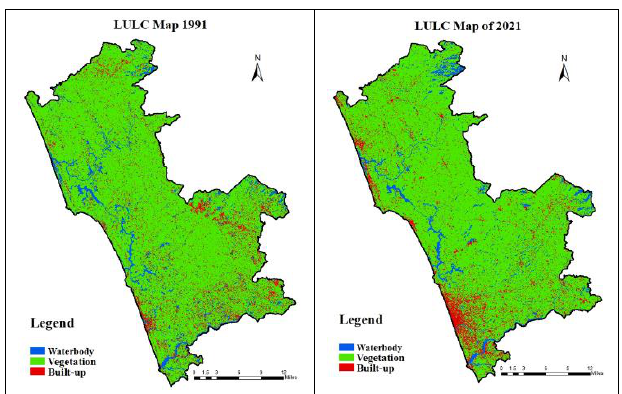
Figure 4 (a) Landcover map of 1991, (b) Landcover map of 2021